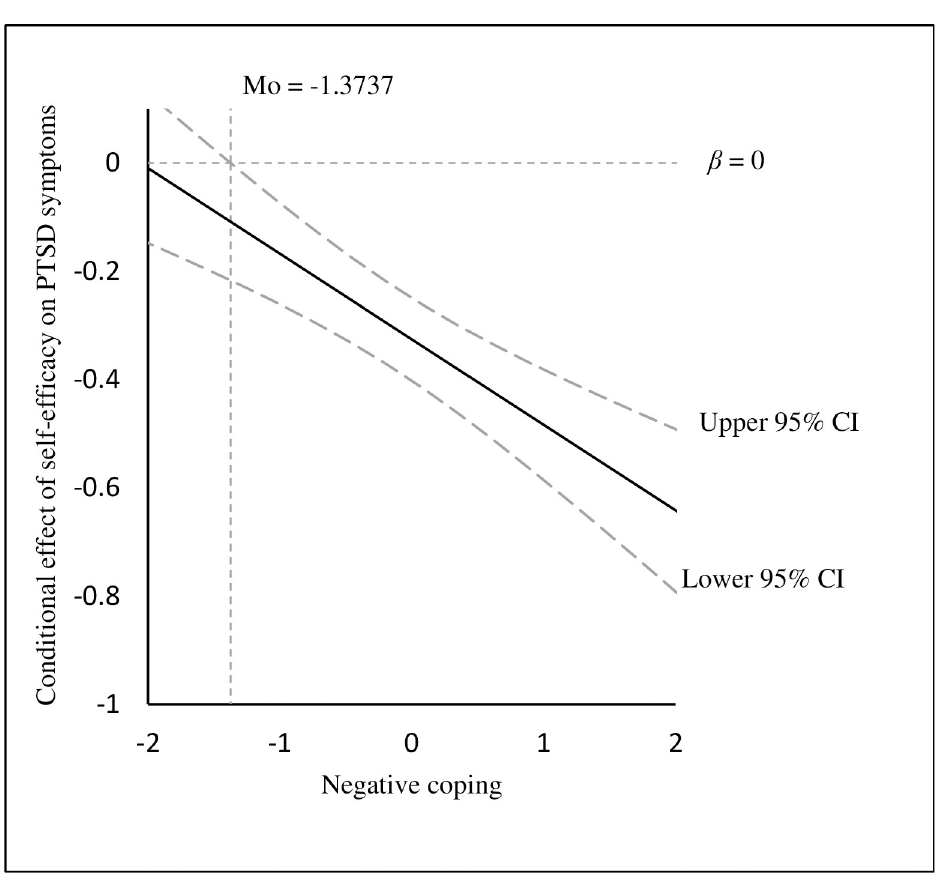
Fig 3. The conditional effect of self-efficacy on PTSD symptoms at the values of negative